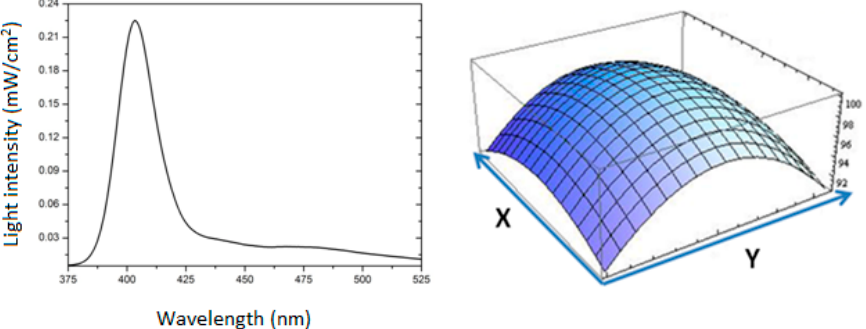
Figure A1. LED lamp with its emission spectrum and surface light distribution. For details refer to point 4.8 in materials and methods section.